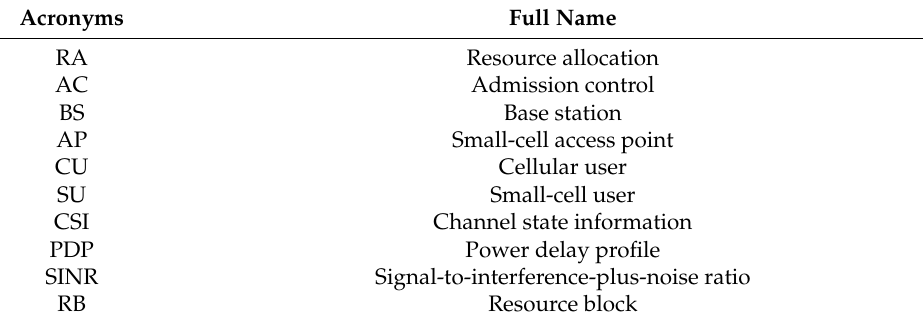
Table 1. Cont. Symbols Description T Slots per frame SINR for the user u of cell c , when it shares the channel with user v of ( bv ) γ cus cell b on subchannel s R cu Average rate of user u of cell c over one slot P c Power budget per frame in cell c T Power spent by BS/AP c for user u on subchannel s a cus Allocation variable of user u of cell c for subchannel s Noise power per subchannel Power of estimation error for user u of cell c Number of pilots/Number of data symbols